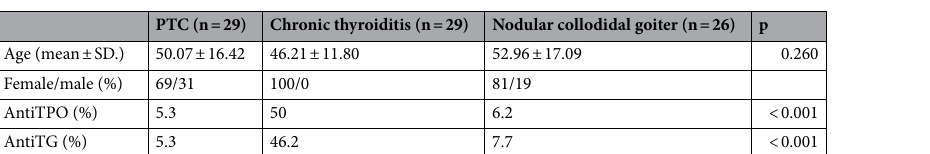
Table 1. Demographic characteristics of patient groups and comparison of